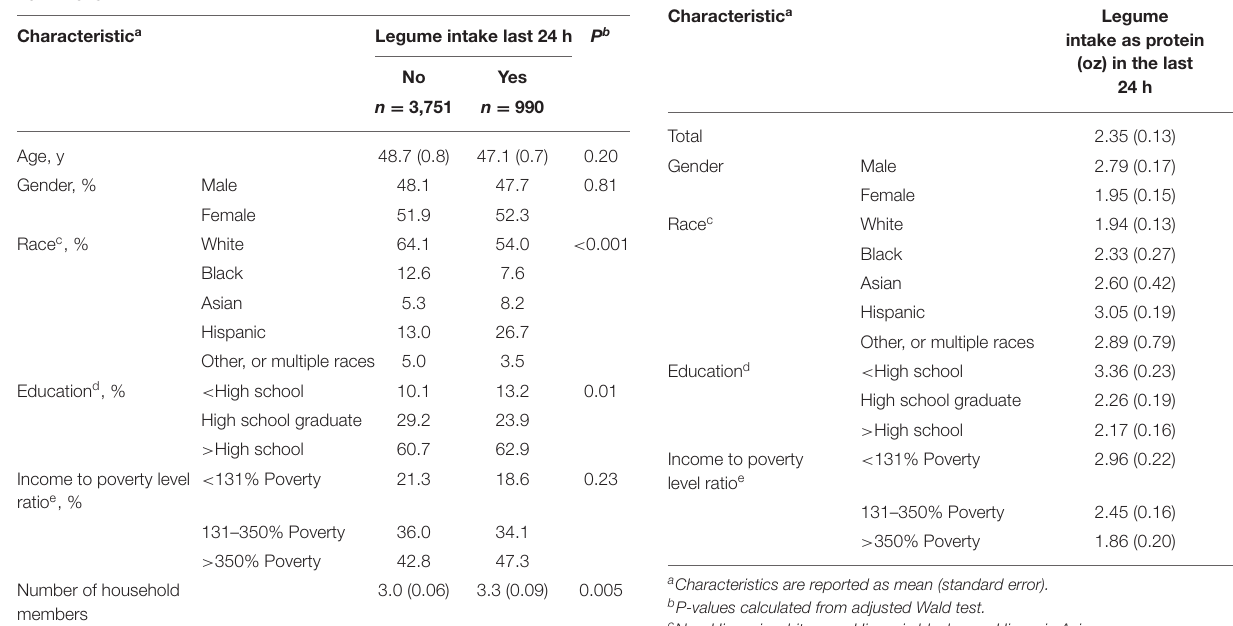
c Non-Hispanic white, non-Hispanic black, non-Hispanic Asian. d Missing n = 8 values for education. e Missing n = 558 values for poverty income ratio.